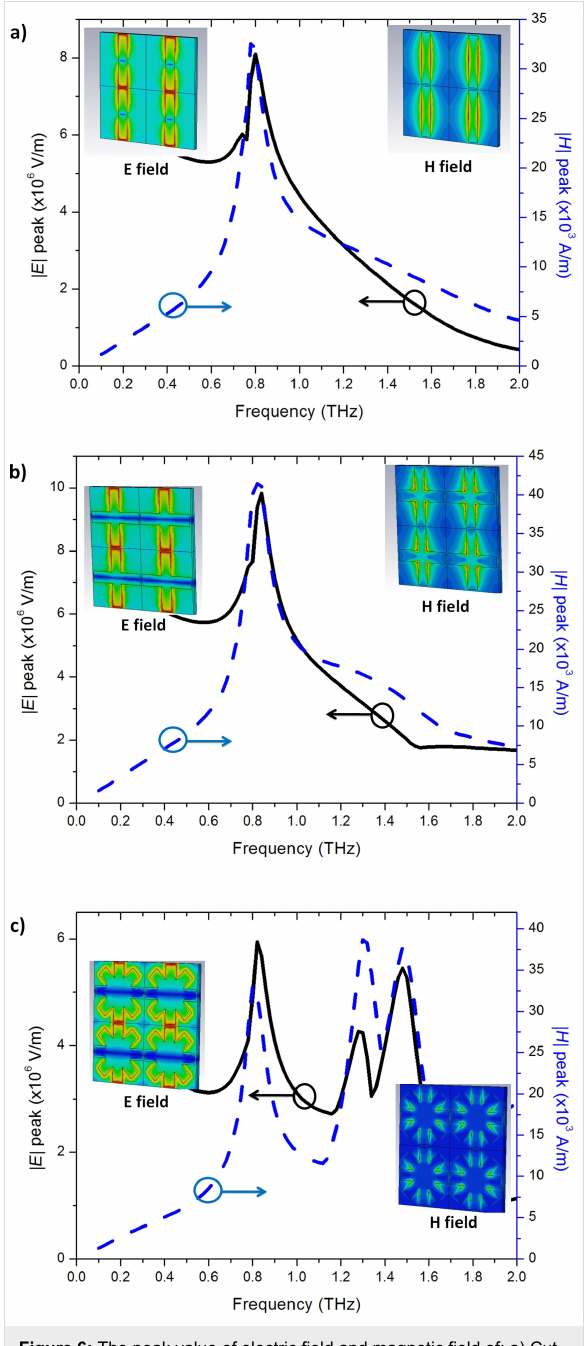
Figure 6: The peak value of electric field and magnetic field of: a) Cut- wire sandwich structure, b) cross-shaped sandwich structure, and c) star-shaped sandwich structure. The insets of (a–c) in each panel show electric and magnetic field distributions of the cut-wire sandwich structure at 0.78 THz, cross-shaped sandwich structure at 0.82 THz, and star-shaped sandwich structure at 0.81 THz,